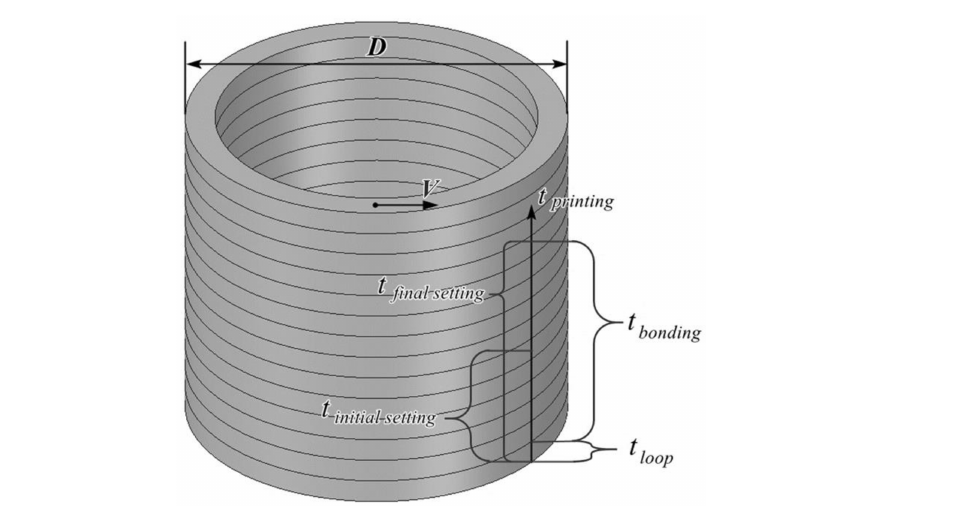
Figure 5. Parameters used to determine the BI including diameter ( D ), printing speed ( V ), loop time ( t loop ), initial setting time ( t initial ), final setting time ( t final setting ), and the bonding time ( t bonding ).